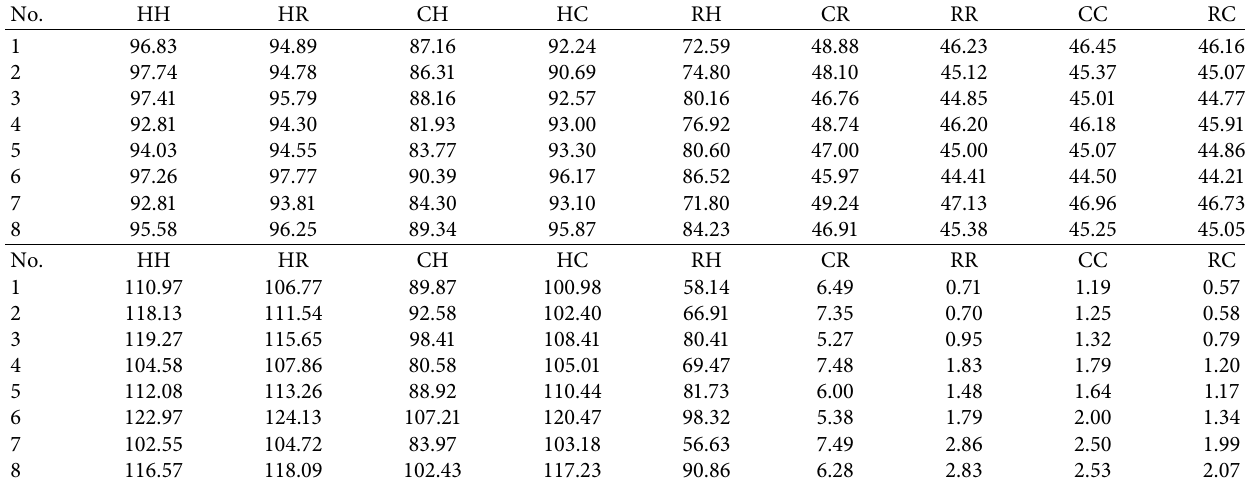
Table 7: Mean percentage qualities of the best-found schedules returned by the LS algorithms (the top table) and mean percentage improvement of the lengths of schedules returned by the LS phase with respect to the lengths of schedules returned by the initialization phase (the bottom table) for each of the eight classes of SCP1 with cov � 90%.